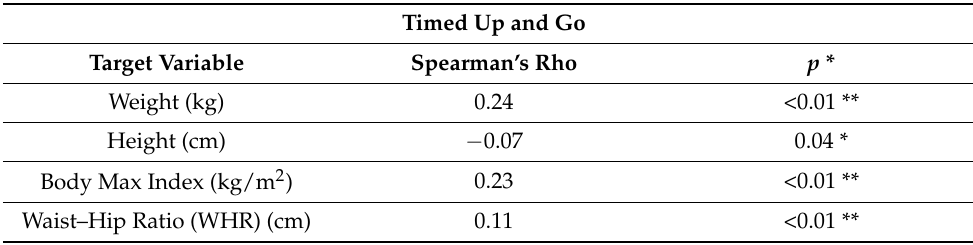
Table 3. Correlation between Timed Up and Go test and anthropometric data in physically active older women with depression ( n =